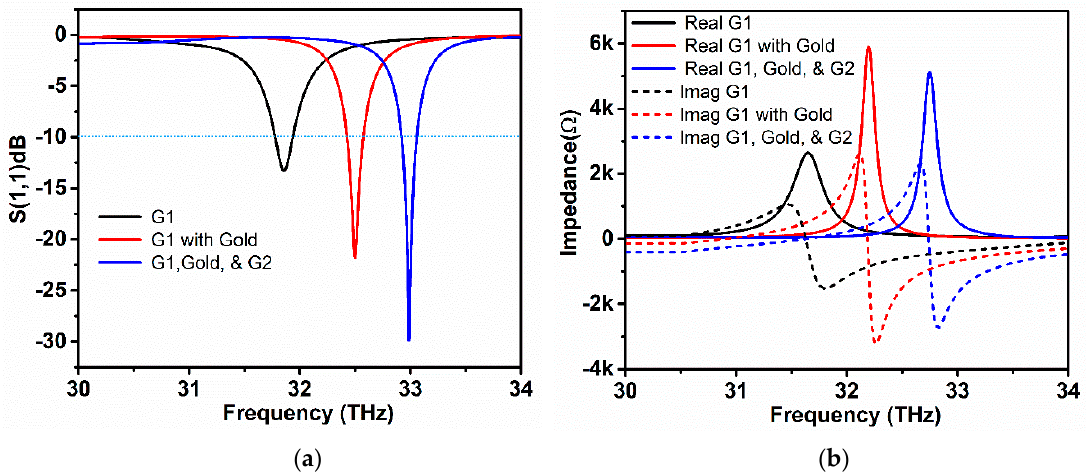
Figure 5. ( a ) Reflection coefficient of the proposed graphene-metal antenna and the effect of stacking symmetry on the S 11 ; and, ( b ) Input impedance Real and Imaginary part corresponding to the resonance frequencies of stacking